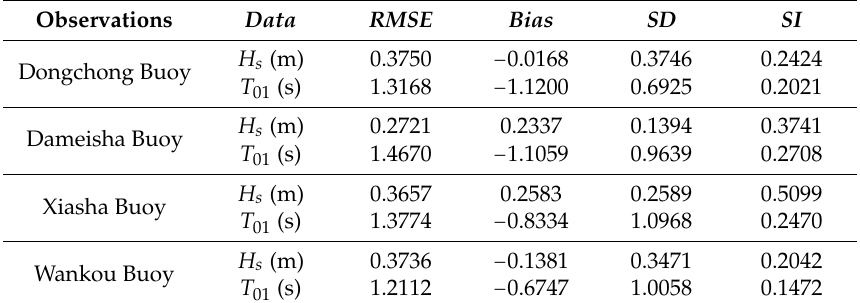
Table 6. Summary of the statistical errors for the simulations during Typhoon Matmo process from 20 to 24 July 2014.